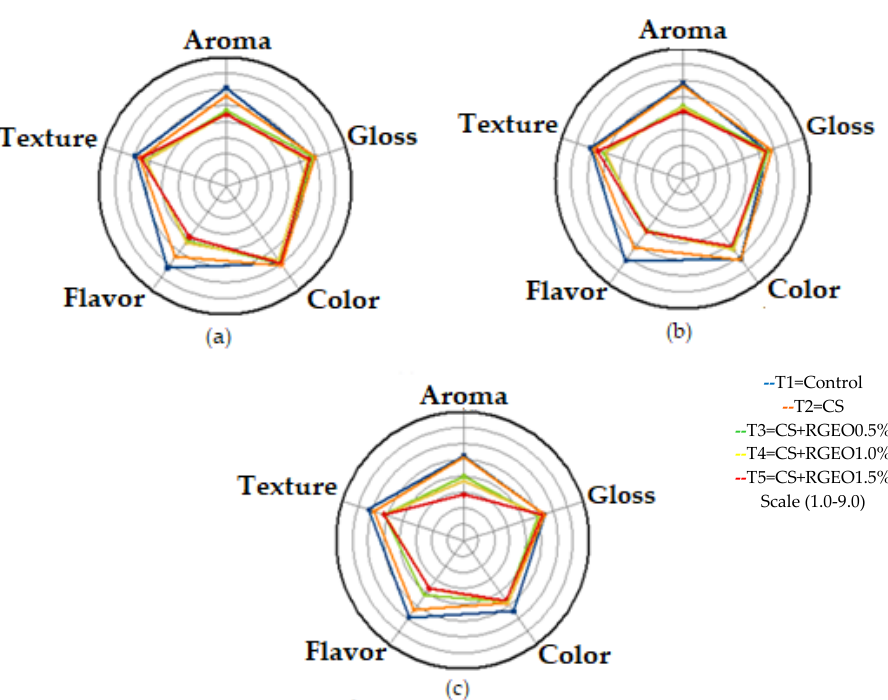
Figure 6. The hedonistic scale of the sensory analysis on days 0 ( a ), 3 ( b ), and 6 ( c ).